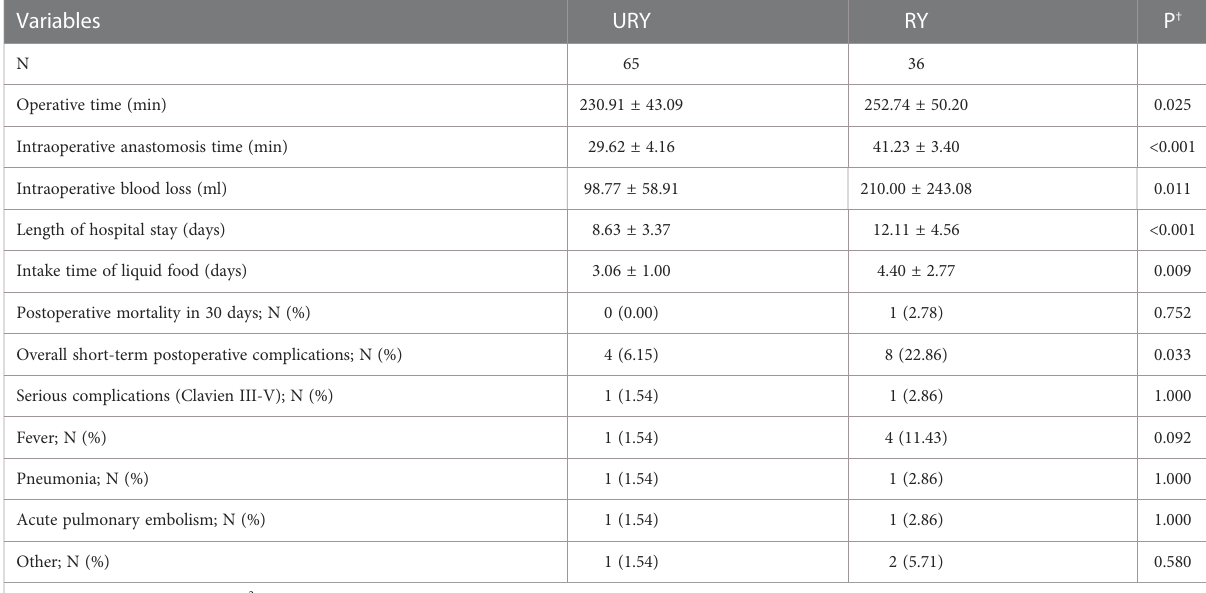
TABLE 2 Perioperative conditions.